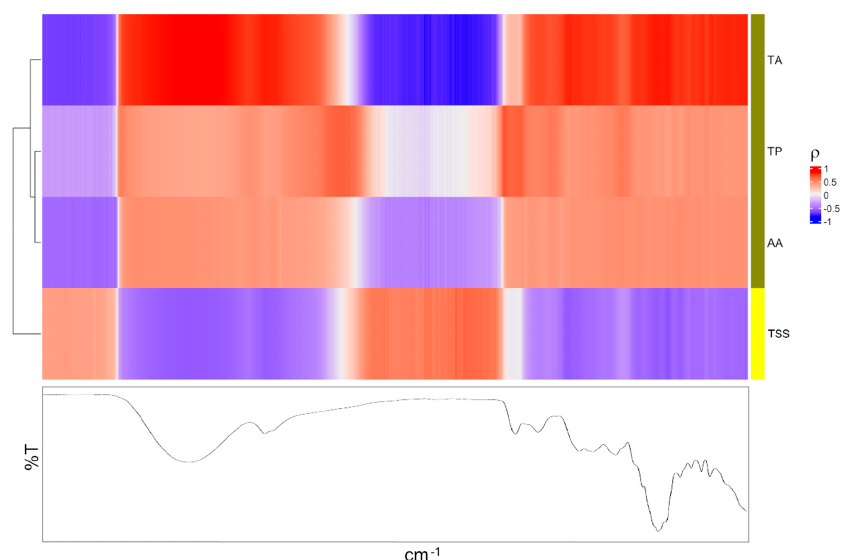
Figure 5. Correlations between ATR-FTIR and chemical data: heatmap; a different colour code was used to represent the clusters discovered by cluster analysis; ρ is the Pearson correlation coefficient; in the bottom, the average IR spectrum is reported.